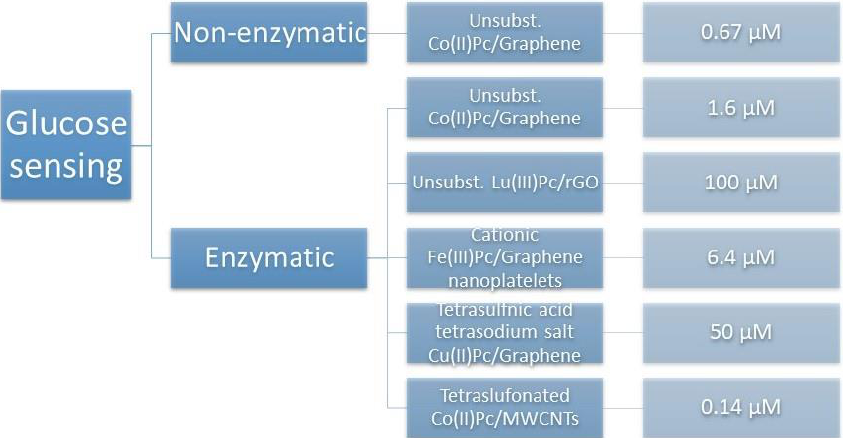
Figure 10. Examples of recognition elements based on azaporphyrins/carbon-based nanomaterials (CBNs) used in glucose determination with the obtained limits of detection.